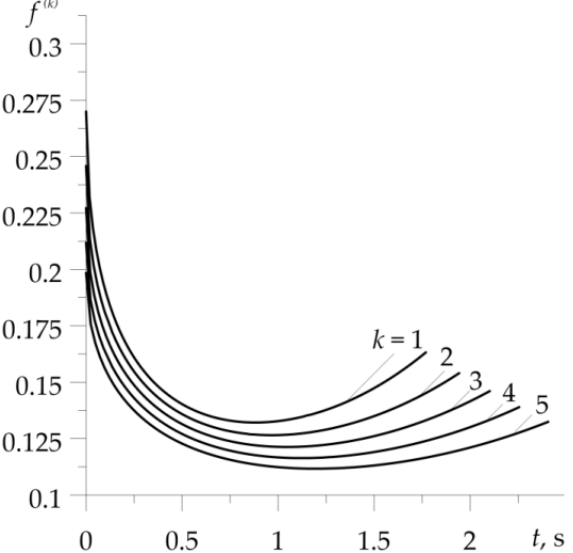
( k ) (21) during five successive braking Figure 6. Evolution of friction coefficient ) ( k f (21) during five successive braking cycles. Figure 6. Evolution of friction coefficient f